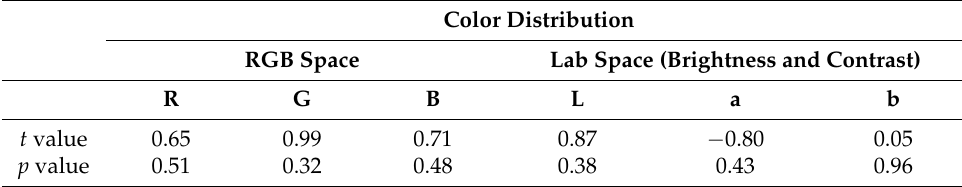
Table A2. Comparison of color distribution (RGB and Lab) between the Twin Sets (Experiment 1). Color